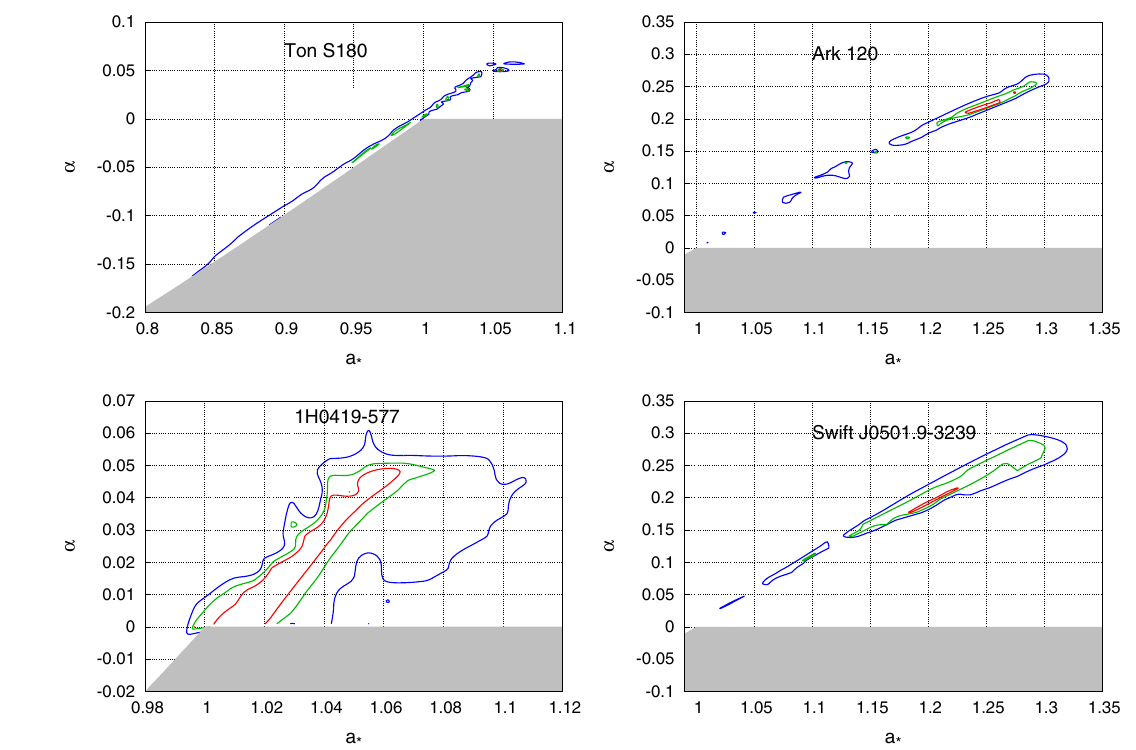
Fig. 5 Constraints on the spin parameter a ∗ and the deformation parameter α for the four sources of our study. The red, green, and blue curves correspond, respectively, to the 68%, 90%, and 99% confidence